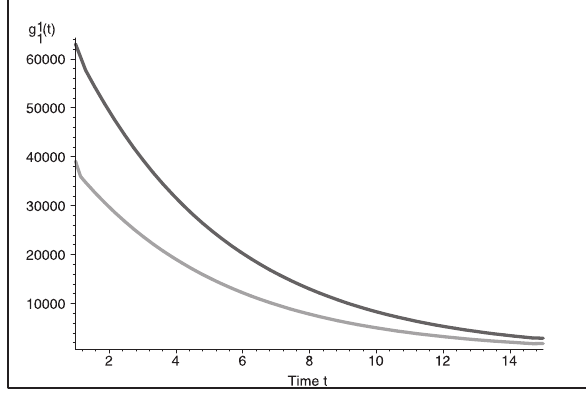
Figure 3. Instantaneous payoffs: dark—cooperation, light—Nash